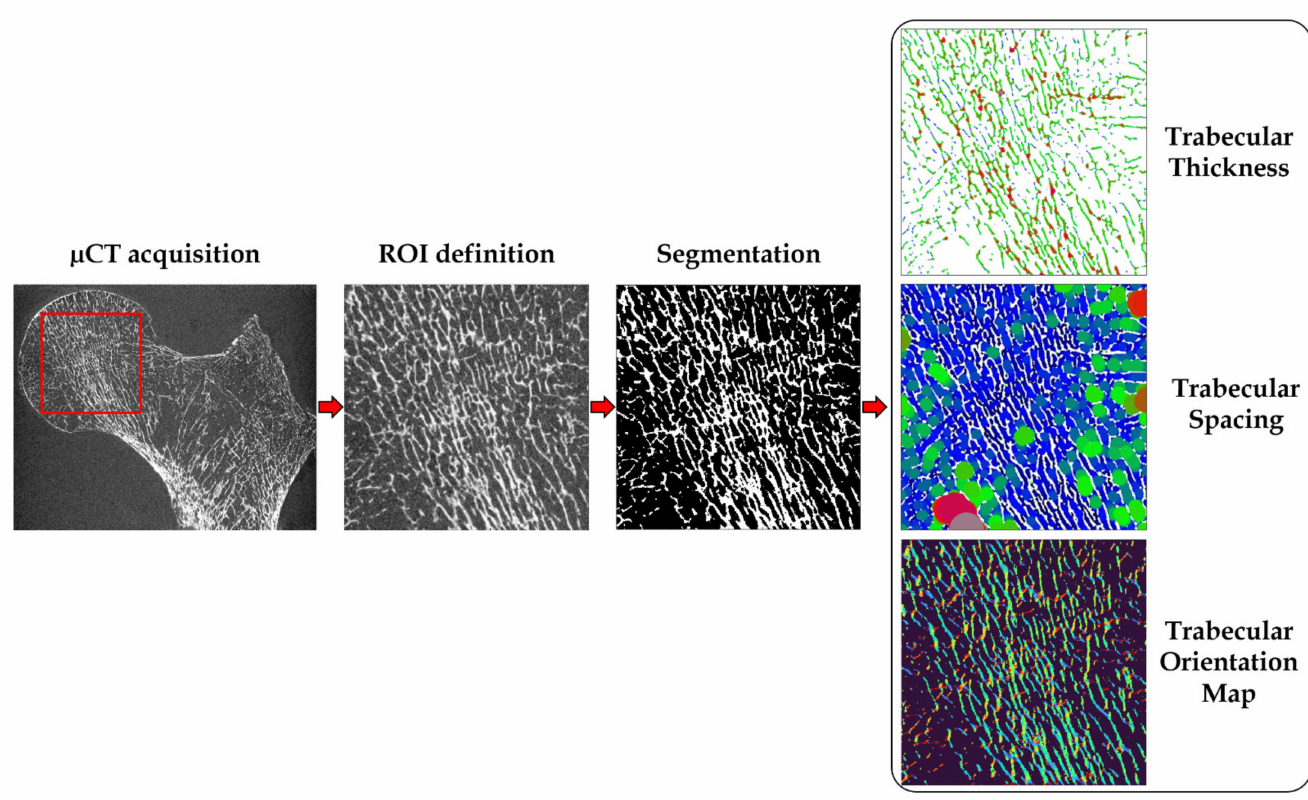
Figure 3. Preprocessing and elaboration steps for the microarchitecture characteristics